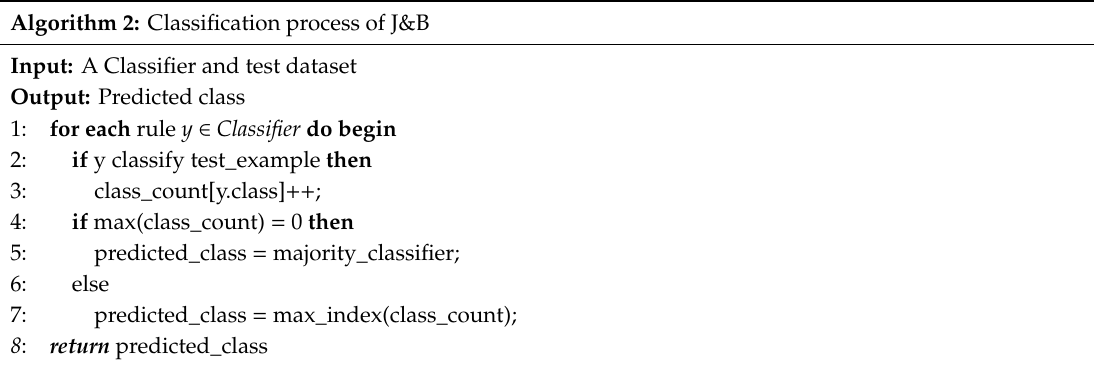
Algorithm 2: Classification process of